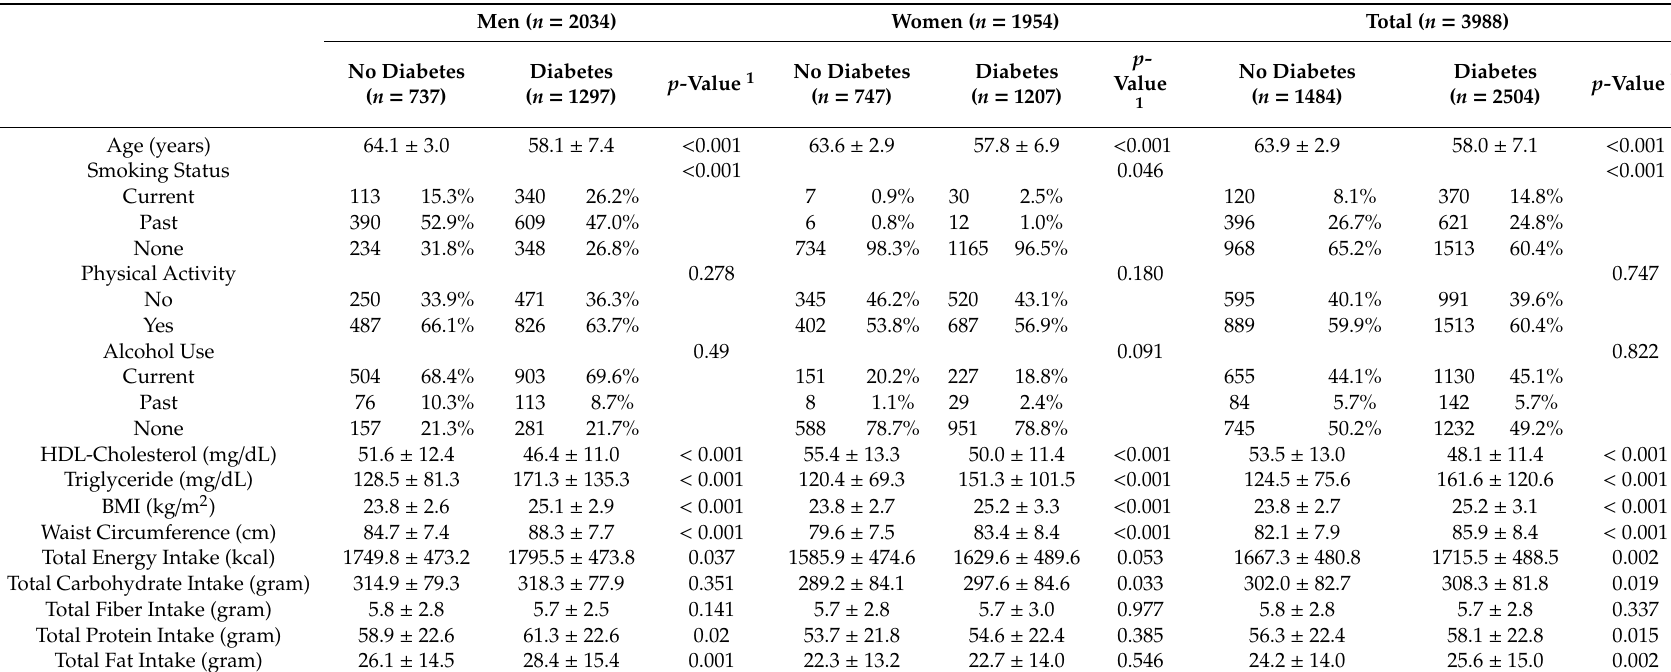
Table 1. General characteristics of study participants according to the absence and presence of diabetes in Korean men and